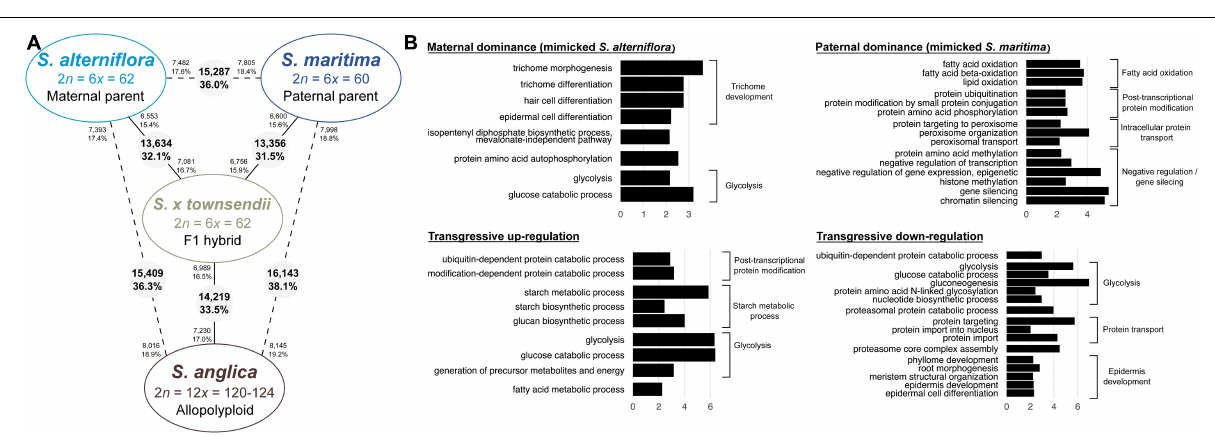
FIGURE 6 | Transcriptomic changes following hybridization and whole genome duplication in Spartina . (A) Number of differentially expressed genes between species (pairwise comparisons). The numbers in grey circles represent the number of orthologs differentially expressed among the 42,423 analyzed clusters. The numbers of upregulated orthologs are represented near species names. (B) Bar graph of the most enriched GO-terms (biological process) for non-additively expressed orthologs in the F1 hybrid and in the allopolyploid (expressed under parental dominance or transgressive). GO-terms were grouped according to their metabolic pathway affiliation. The X -axis corresponds to the negative logarithm of adjusted p -value. The complete list of enriched GO terms is available in Supplementary Tables 6, 7 .